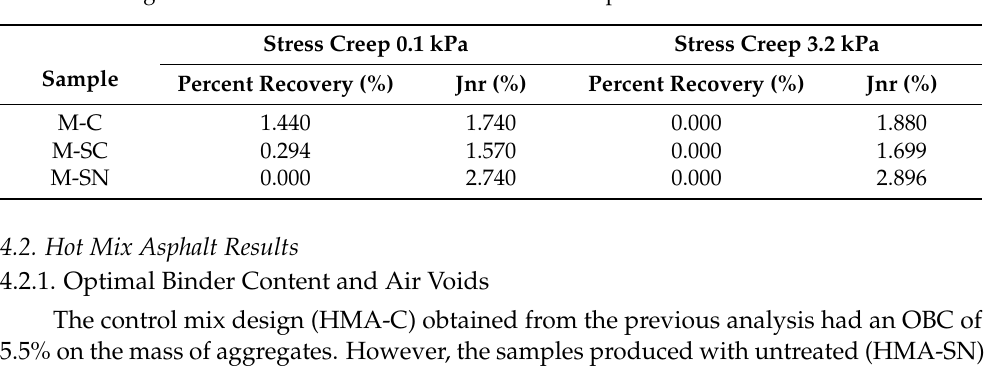
Table 2. Average recoverable strain and non-recoverable compliance at the two stress